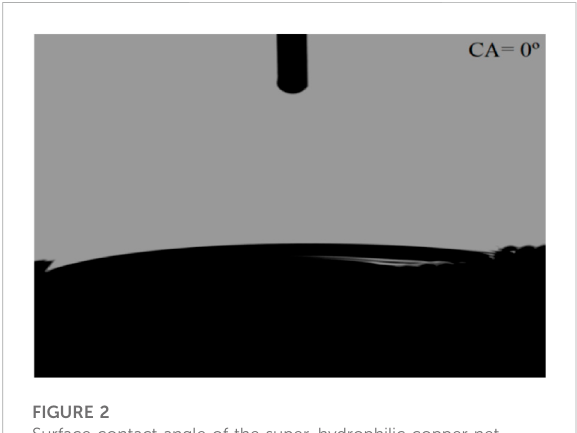
FIGURE 2 Surface contact angle of the super-hydrophilic copper